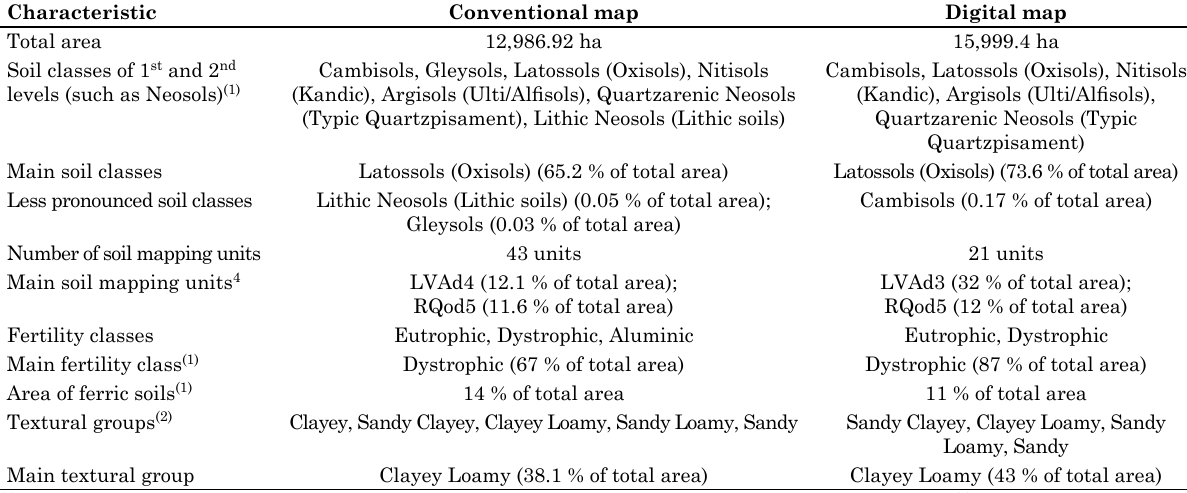
table 3. Comparisons among several characteristics observed in the digital and conventional soil maps